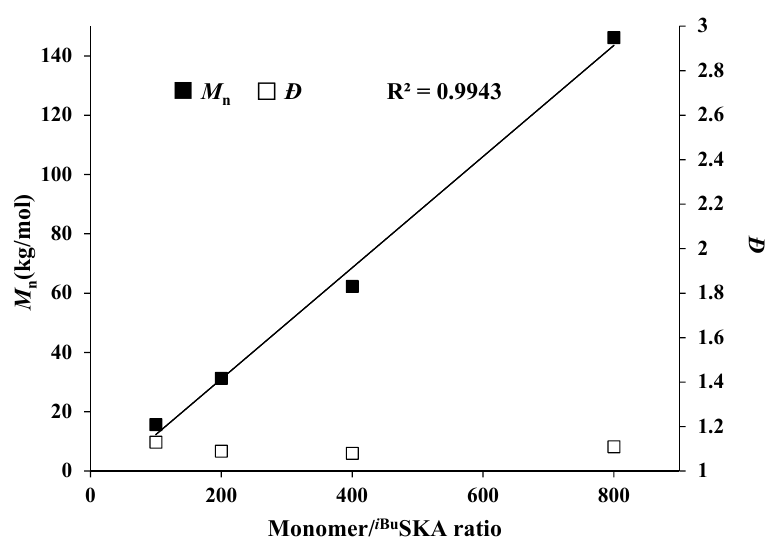
400:0.5:1, [MMBL] 0 = 0.936 M.